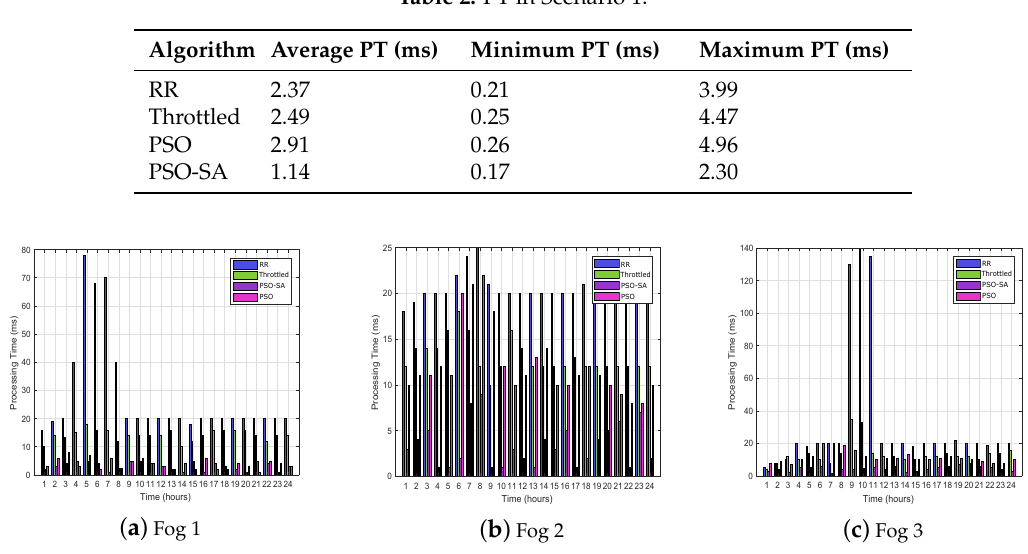
Table 2. PT in Scenario 1.